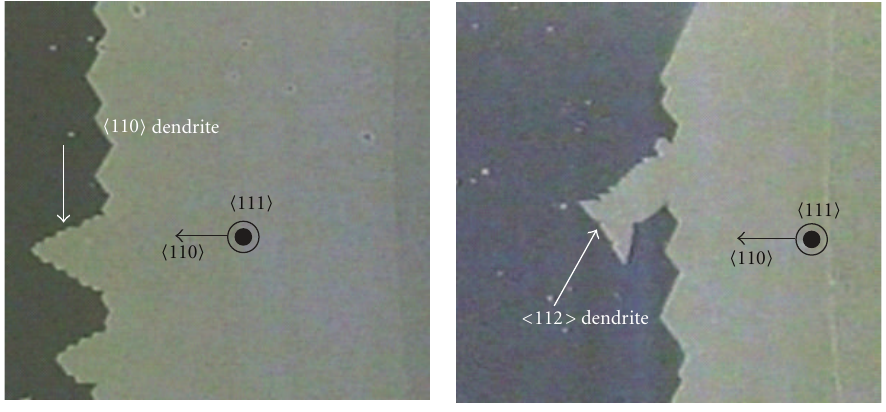
Figure 15: Growth shape of Si (cid:4) 112 (cid:5) and (cid:4) 110 (cid:5) faceted dendrites [73].